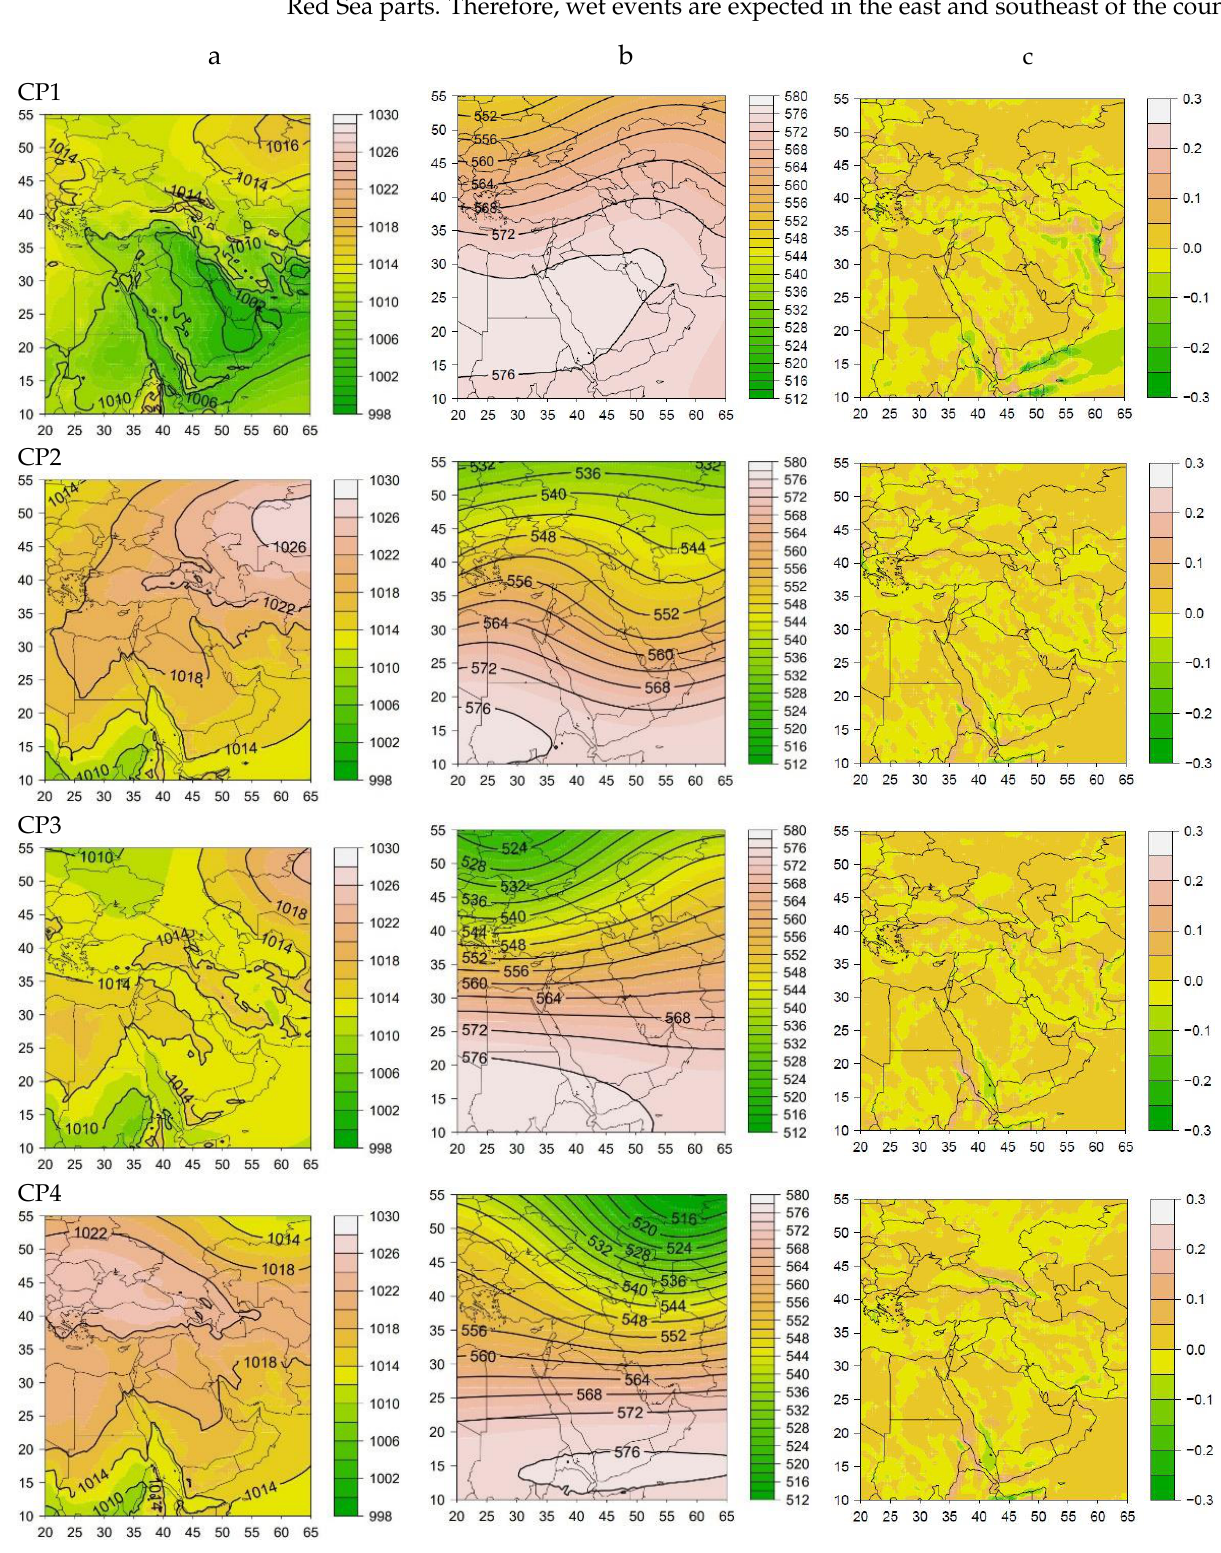
Figure 2. Atmospheric circulation patterns in Iran in the period of 1990–2019 for patterns CP1 to CP4, ( a ) average sea surface pressure (hPa), ( b ) average geopotential height of 500 hPa (dm), and ( c ) average moisture flux divergence ( grkg −1 s −1 ) (convergence with negative values in green). Circulation pattern 5: Similarly, to pattern 2, the Siberian high pressure with a center of 1026 hPa has penetrated to the northern half of Iran. At the level of 500 hPa, the trough extends east of the Caspian Sea towards the east of Iran. At the same time, a ridge stretches